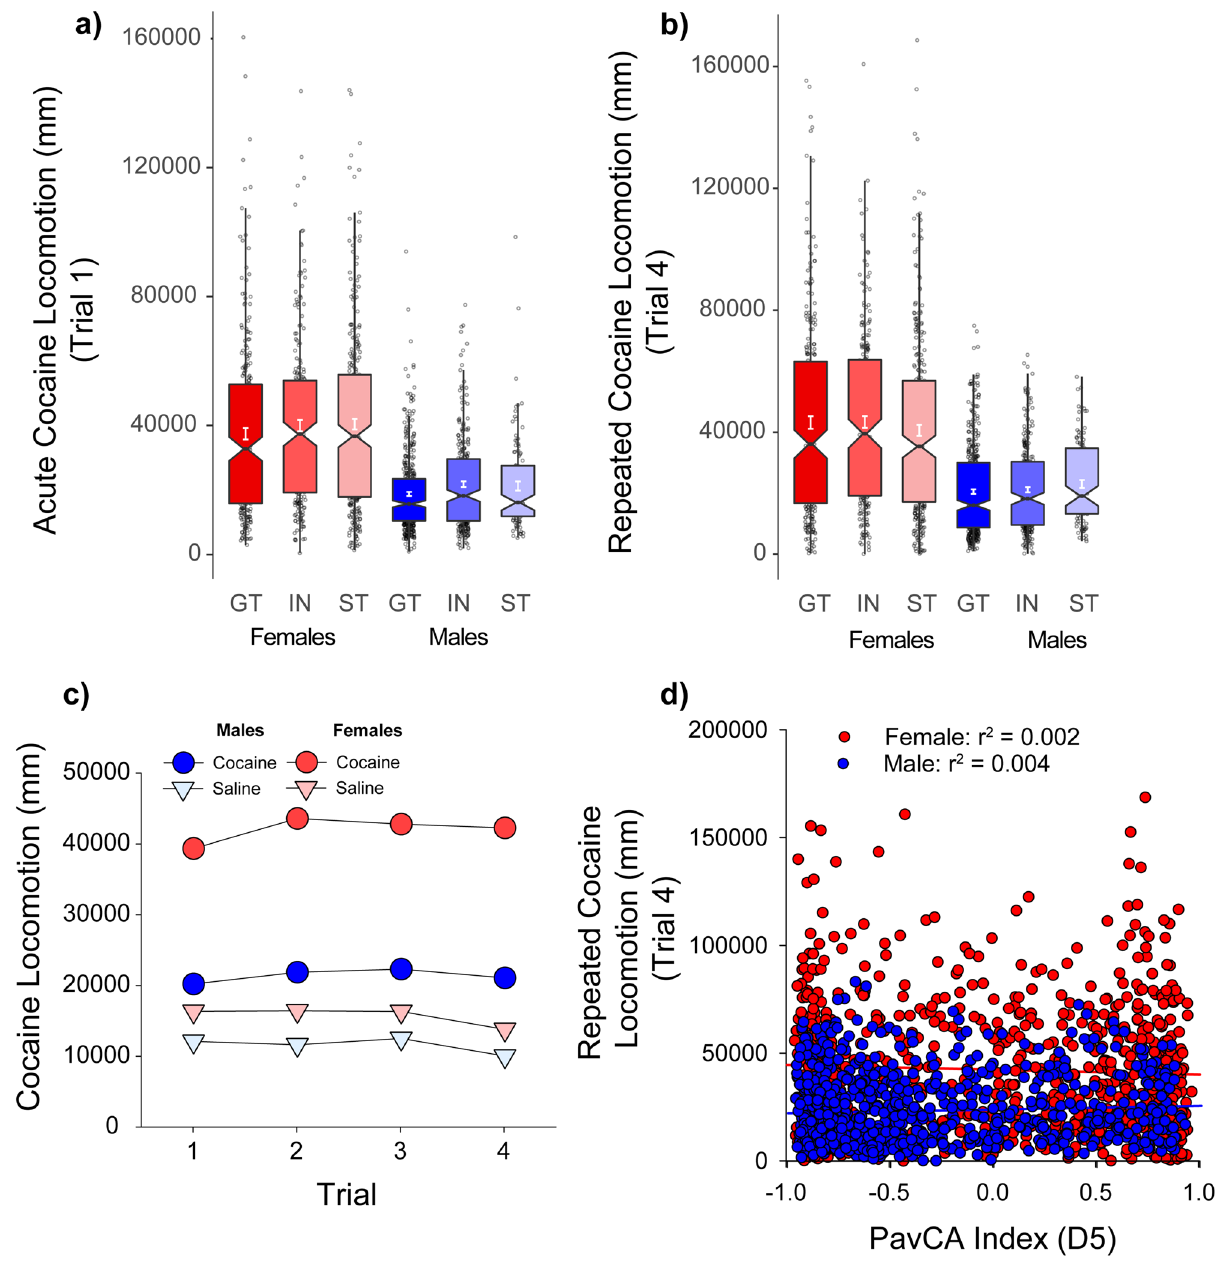
Figure 4. Unconditioned locomotor response during Conditioned Cue Preference (CCP) (UBuff): Rats showed robust locomotor activation to cocaine across 4 trails of conditioning. On the first trial ( a ) females showed larger cocaine-induced locomotion compared to males, although this effect was not different between intermediates (IN), sign- (ST), or goal-trackers (GT). ( b ) This sex difference persisted to the fourth trial of conditioning. ( c ) Cocaine induced larger locomotor activity compared to saline across trials, and this effect sensitized between sessions 1 and 4. ( d ) PavCA index is largely unrelated to cocaine induced locomotion at the end of conditioning in both males and